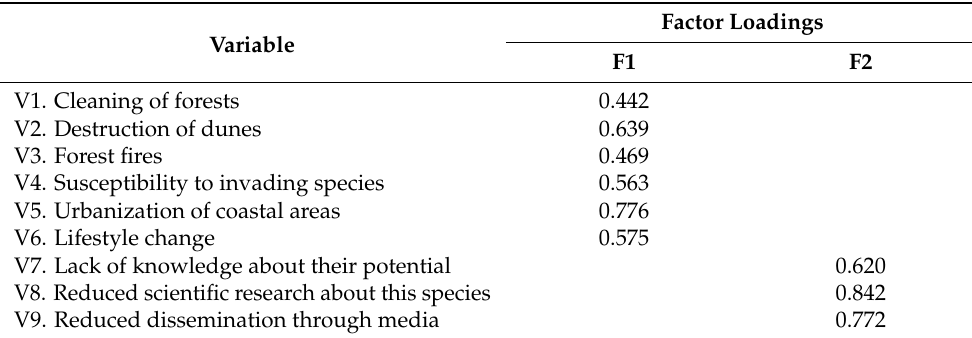
Table 2. Factor analysis to the possible causes that can contribute to the endangerment of the crowberry